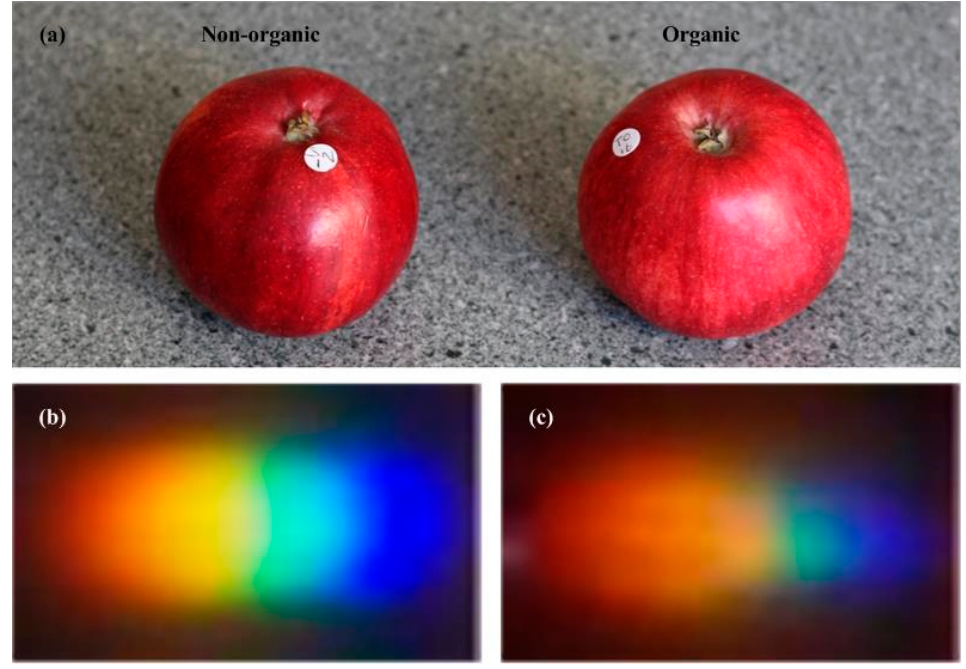
Figure 5. ( a ) Non-organic ( left ) and organic apple ( right ); ( b ) The rainbow image of an organic apple; ( c ) The rainbow image of a non-organic